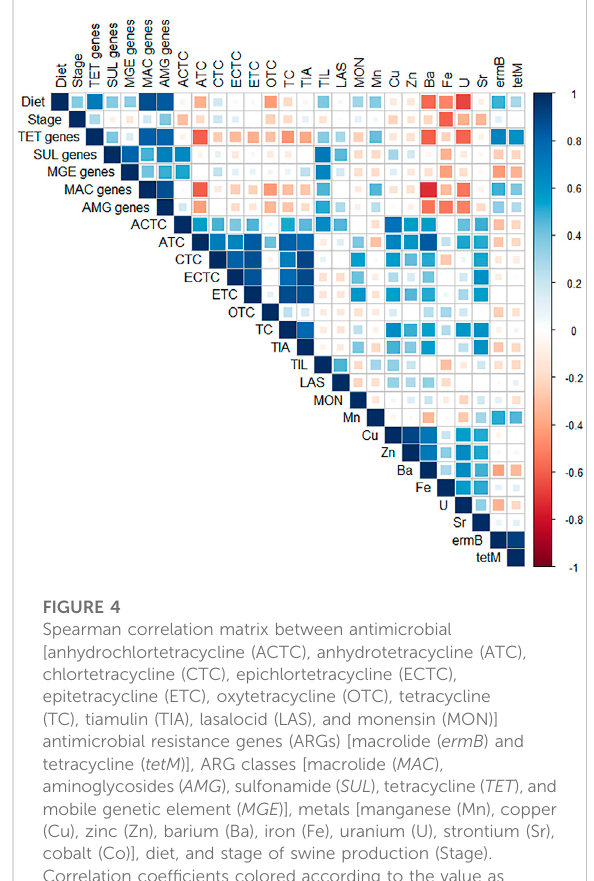
FIGURE 4 Spearman correlation matrix between antimicrobial [anhydrochlortetracycline (ACTC), anhydrotetracycline (ATC), chlortetracycline (CTC), epichlortetracycline (ECTC), epitetracycline (ETC), oxytetracycline (OTC), tetracycline (TC), tiamulin (TIA), lasalocid (LAS), and monensin (MON)] antimicrobial resistance genes (ARGs) [macrolide ( ermB ) and tetracycline ( tetM )], ARG classes [macrolide ( MAC ), aminoglycosides ( AMG ), sulfonamide ( SUL ), tetracycline ( TET ), and mobile genetic element ( MGE )], metals [manganese (Mn), copper (Cu), zinc (Zn), barium (Ba), iron (Fe), uranium (U), strontium (Sr), cobalt (Co)], diet, and stage of swine production (Stage). Correlation coef fi cients colored according to the value as depicted by scale, where a strong positive correlation is indicated by a dark blue box and a strong negative correlation is depicted by a dark red box. Size of squares corresponds to p -value, where correlations with p -value > 0.05 are considered insigni fi cant and therefore left blank. Sulfonamides, spiramycin II and III (SPI2, SPI3), erythromycin(ERY), tylosin (TYL), and cobalt(Co) not included due to lack of detections in > 1 sample, or concentrations <